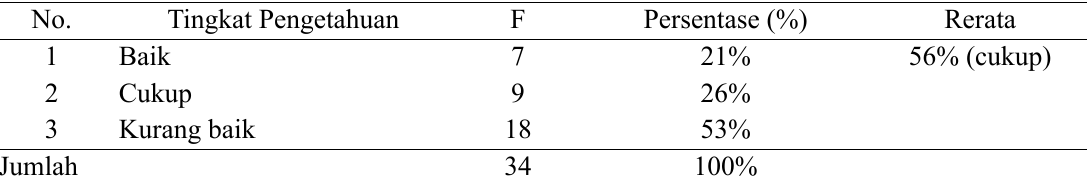
Tabel 3. Distribusi frekuensi pengetahuan (aplikasi) lansia tentang nutrisi di Posyandu lansia No.